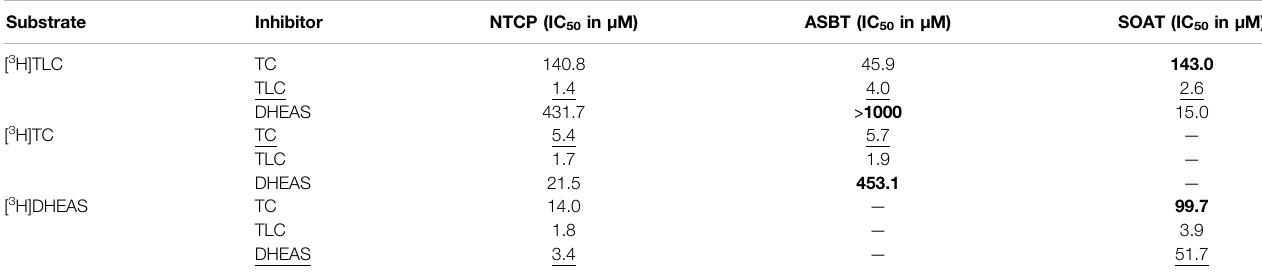
TABLE3| Half-maximalinhibitoryconcentrations(IC 50 )forsubstrateinhibitorsatNTCP,ASBT,andSOAT.[ 3 H]TLC,[ 3 H]TC,and[ 3 H]DHEASsubstrateuptakewasanalyzed inNTCP-HEK293,ASBT-HEK293,andSOAT-HEK293cellsinthepresenceoftheindicatedsubstrateinhibitorsTC,TLC,andDHEASatincreasingconcentrations.The primary transport data are presented in Figure 3 .